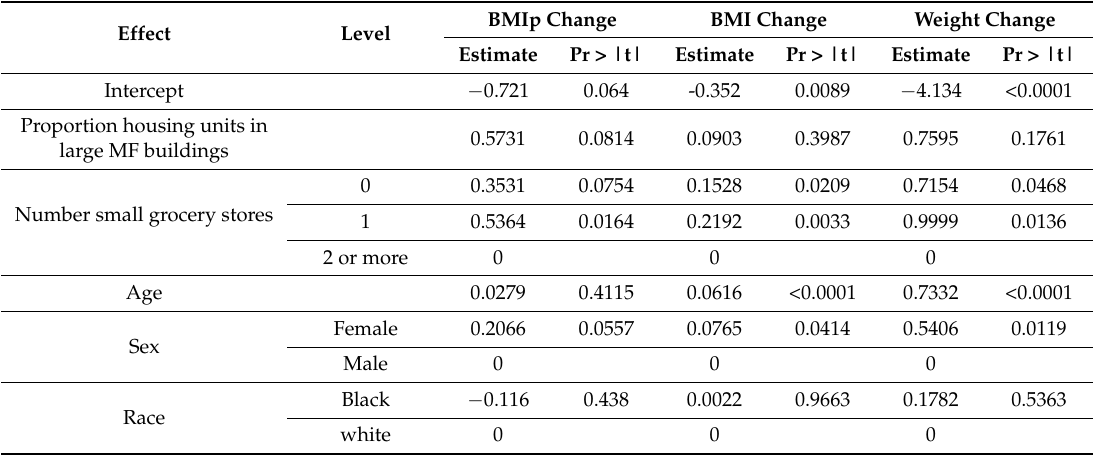
Table 6. Stratified Mixed Model, participants overweight in Spring 2010: Determinants of change in weight status (Outcome: Fall 2010 − Spring 2010).